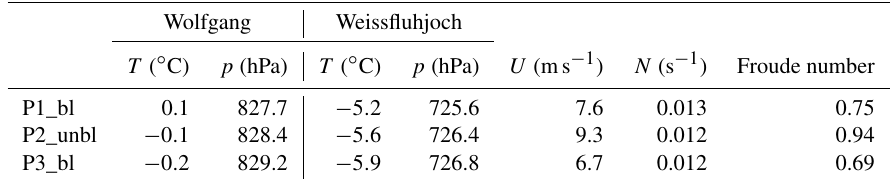
Table A1. Parameters used to calculate the Froude number during P1_bl, P2_unbl and